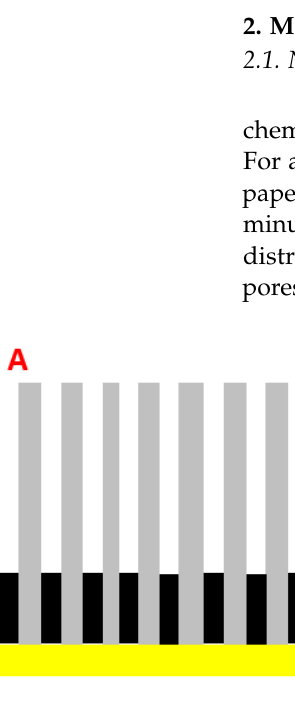
Figure 1. Sketch of Fe-Au electrodeposition through the pores of porous alumina: iron ( A ), addition of gold ( B ), and 3D illustration ( C ).